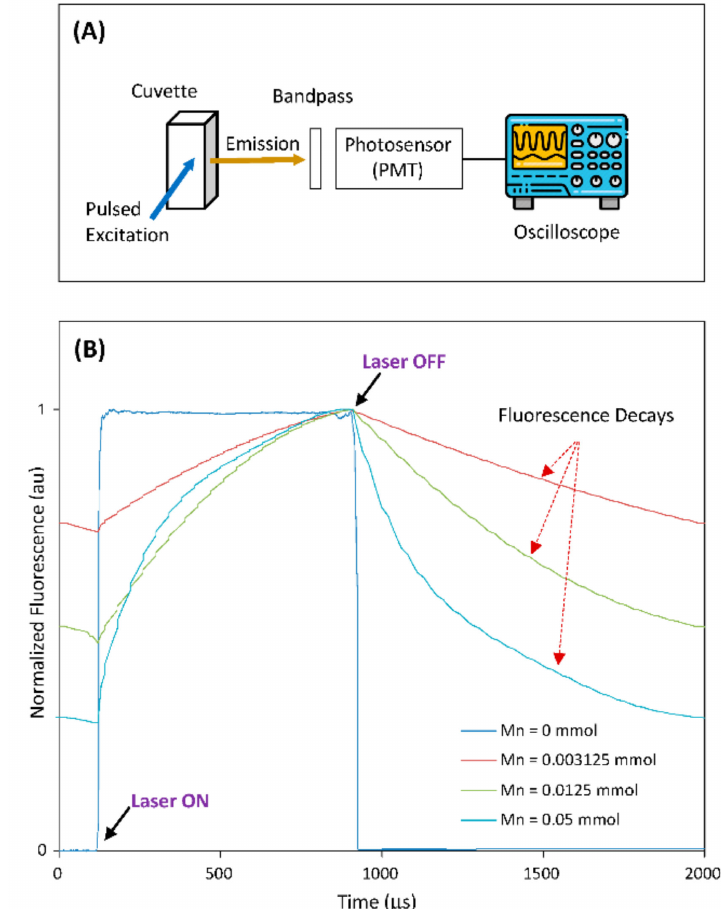
Figure 5. ( A ) The setup illustration of the optical-measurement system. ( B ) The normalized system responses from all selected NCs within a period of laser pulse (host CuGaS-ZnS with Cu/Ga = 1/8, and Mn-doped CuGaS-ZnS with Cu/Ga = 1/8 and Mn = 0.003215, 0.0125, 0.05 mmol,